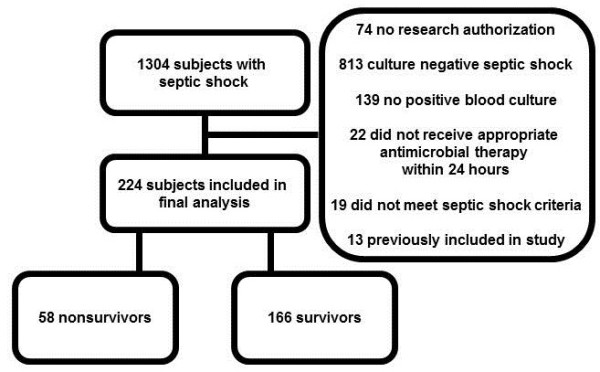
Cohort development.